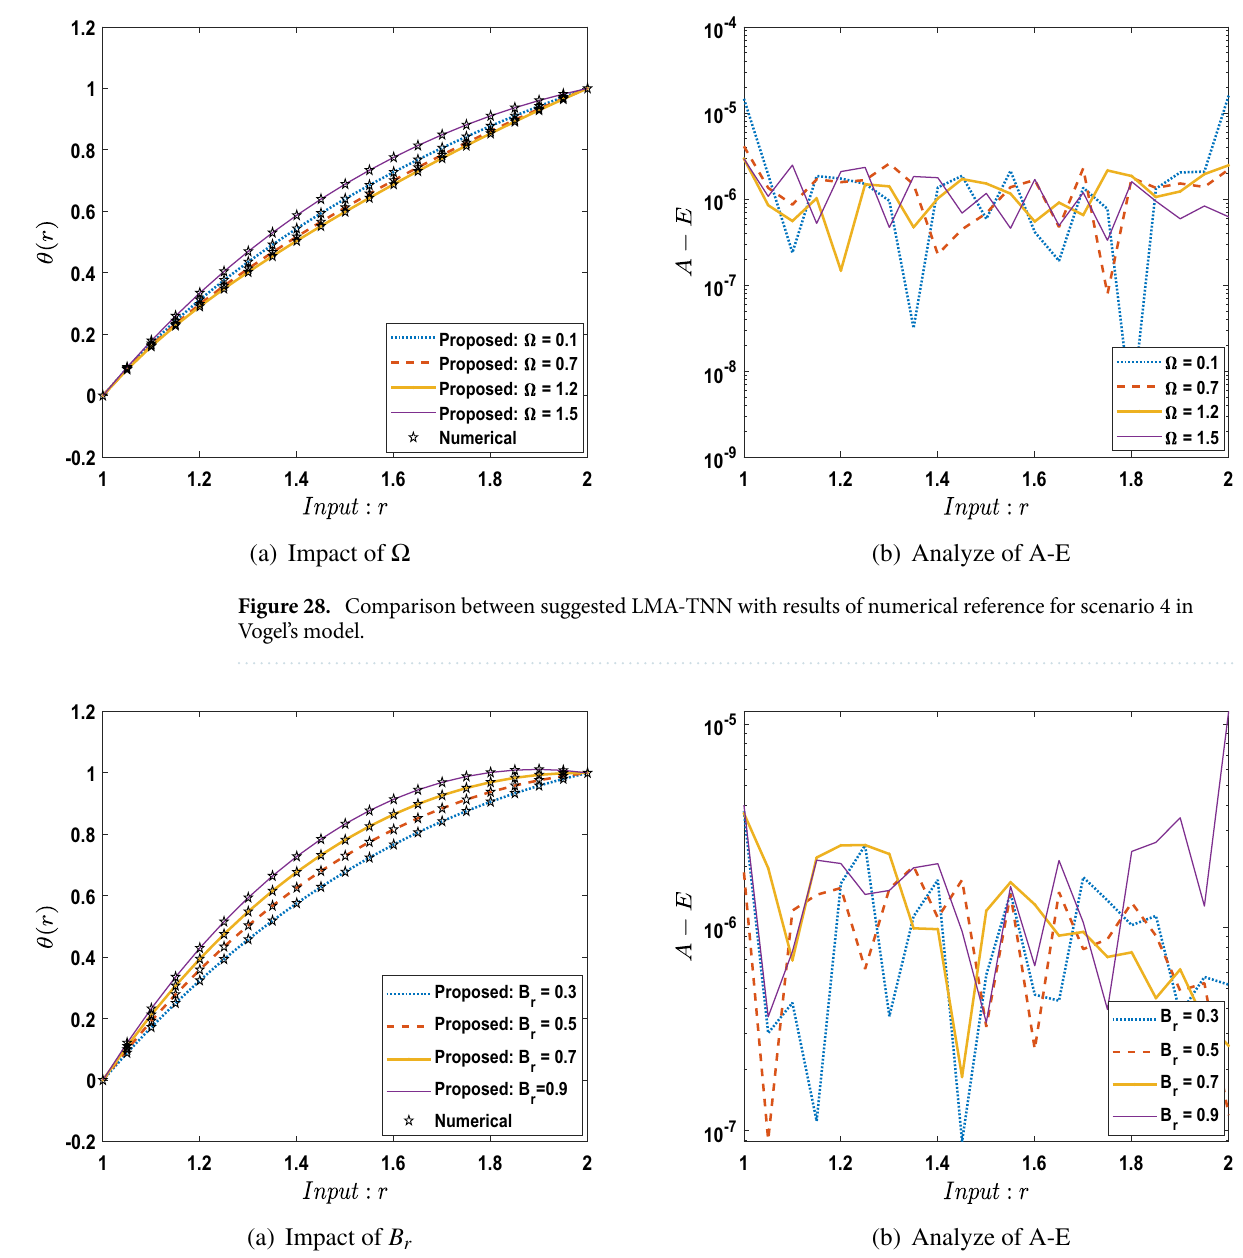
Figure 29. Comparison between suggested LMA-TNN with results of numerical reference for scenario 1 in Reynolds